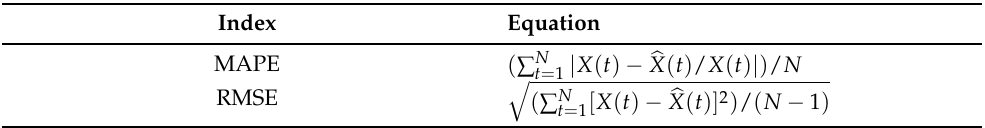
and predicted outputs. Table 4. Definition of two indices for the calculations.